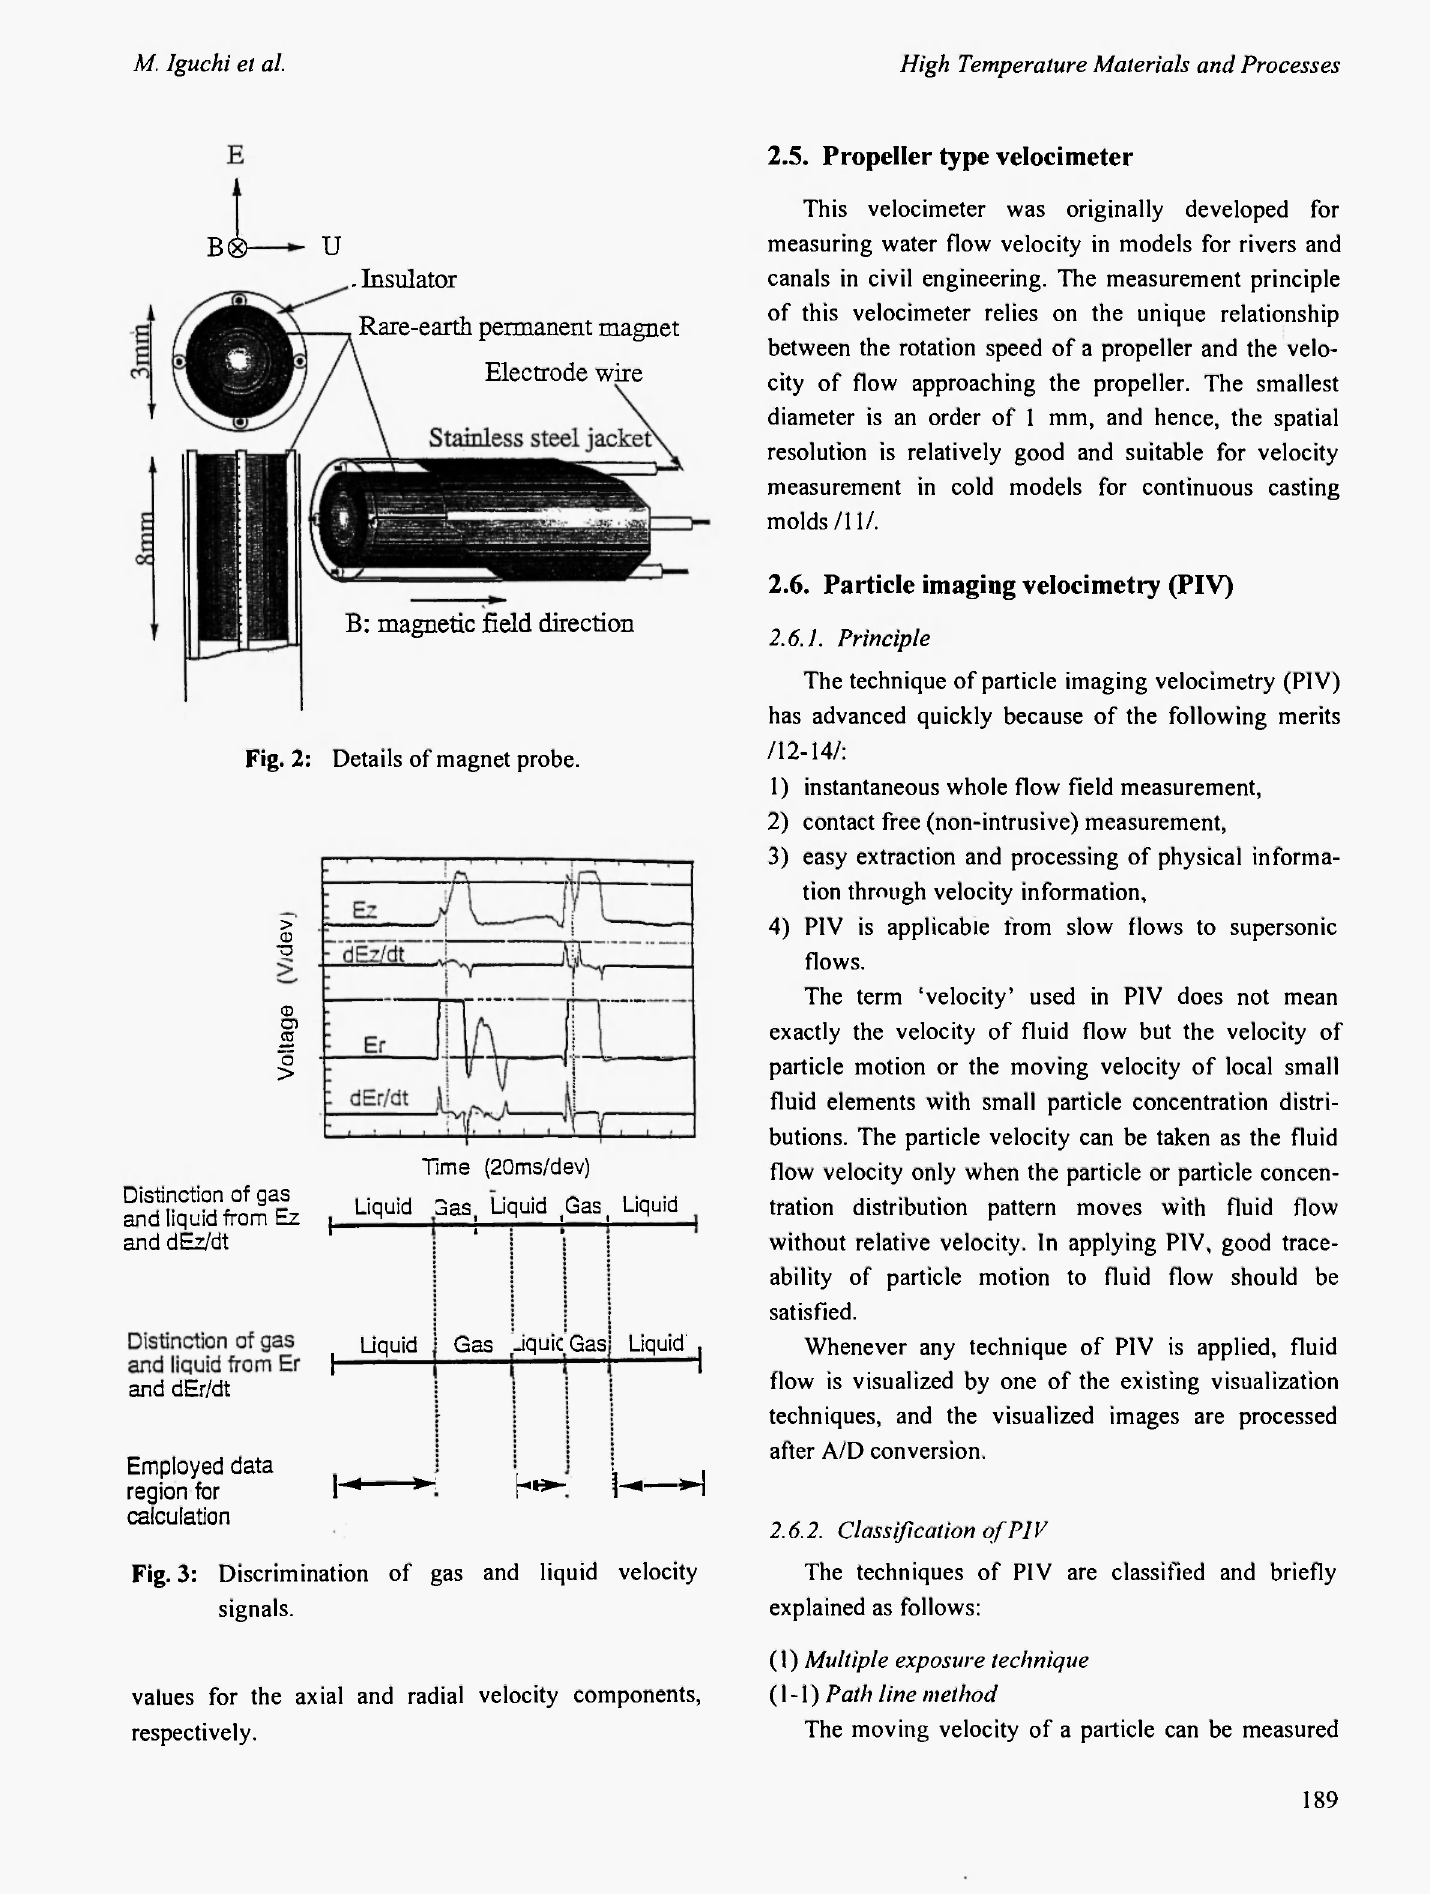
Fig. 3: Discrimination of gas and liquid velocity signals.